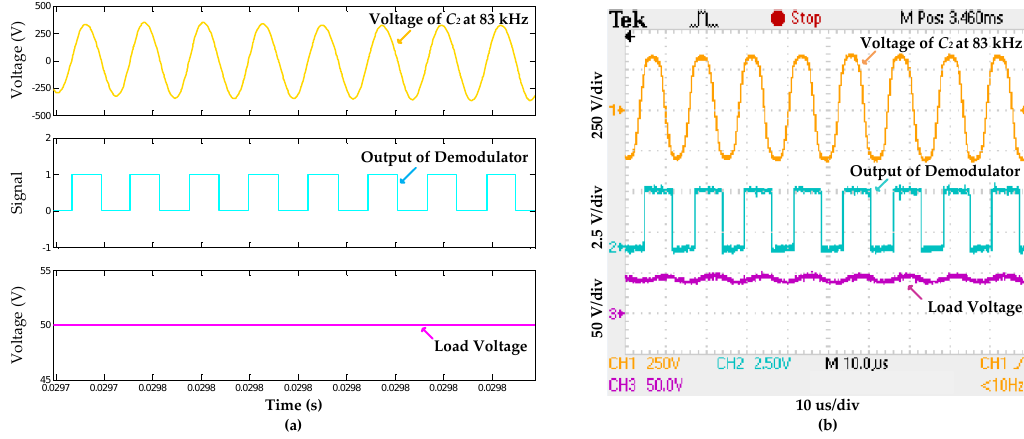
Figure 13. The transmission waveform of power transmission at 83 kHz ( a ) simulation result ( b ) experimental results.